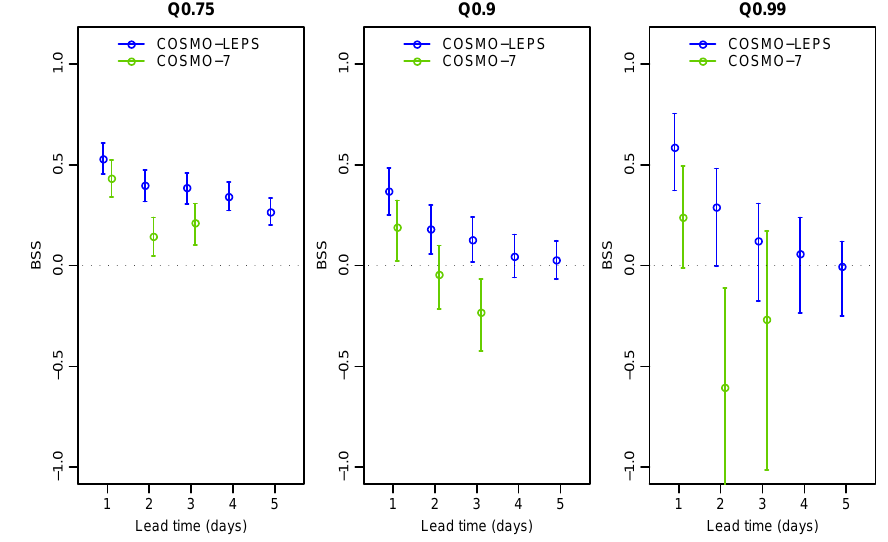
Fig. 4. Brier skill scores (BSS) for COSMO-LEPS- and COSMO-7-based forecasts for the daily maximum Sihl discharge in Zurich. Scores for the discharge thresholds Q 0 . 75, Q 0 . 9 and Q 0 . 99 are shown from left to right. The circles exhibit the raw BSS, while the extremities of the confidence intervals consist of the 5th and 95th percentiles derived by